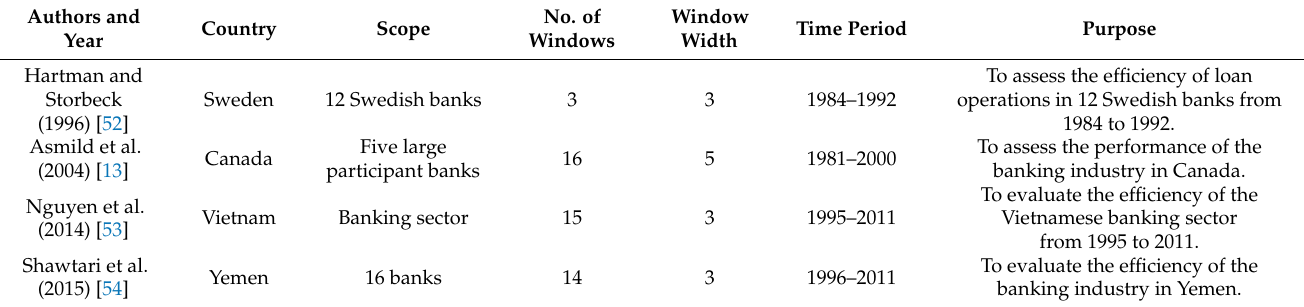
Table 5. Articles classified under the banking